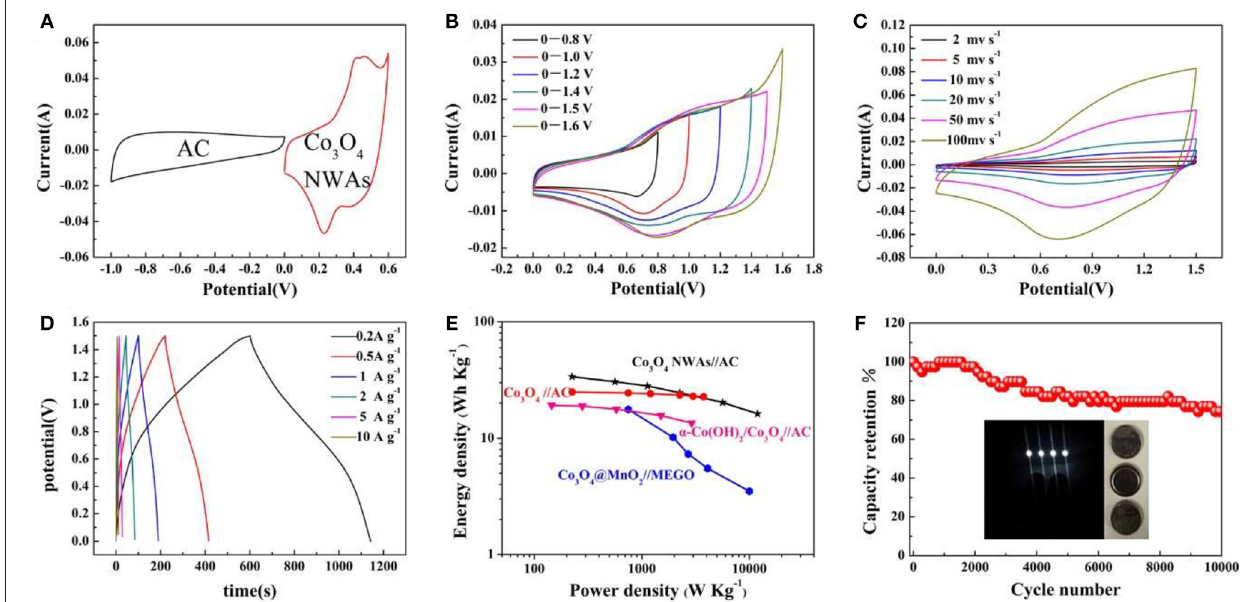
FIGURE 7 | (A) The CV curve of AC electrode and Co 3 O 4 NWAs electrode at a scan rate of 20mV s − 1 , (B) CV curves of Co 3 O 4 NWAs//AC device at different potential ranges, (C) CV curves of Co 3 O 4 NWAs//AC device at different scan rates, (D) GCD curves of Co 3 O 4 NWAs//AC device at different current densities, (E) Ragone plot of the Co 3 O 4 NWAs//AC device, (F) Cycling performance of the Co 3 O 4 NWAs//AC device at a current density of 2A g − 1 (inset is the photo of the lighted LED by the double Co 3 O 4 NWAs//AC